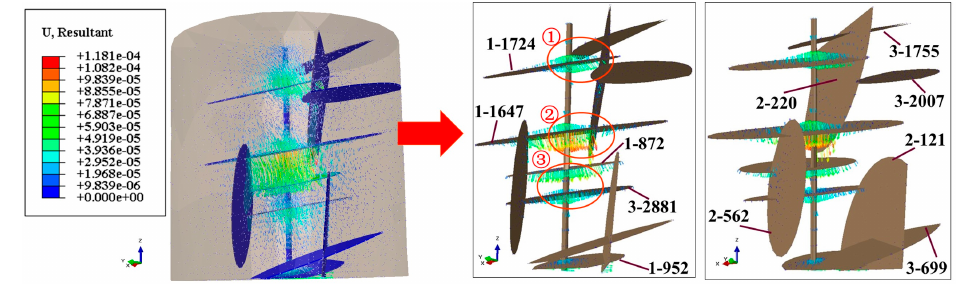
Figure 13. Vectorgraph of fracture displacement.